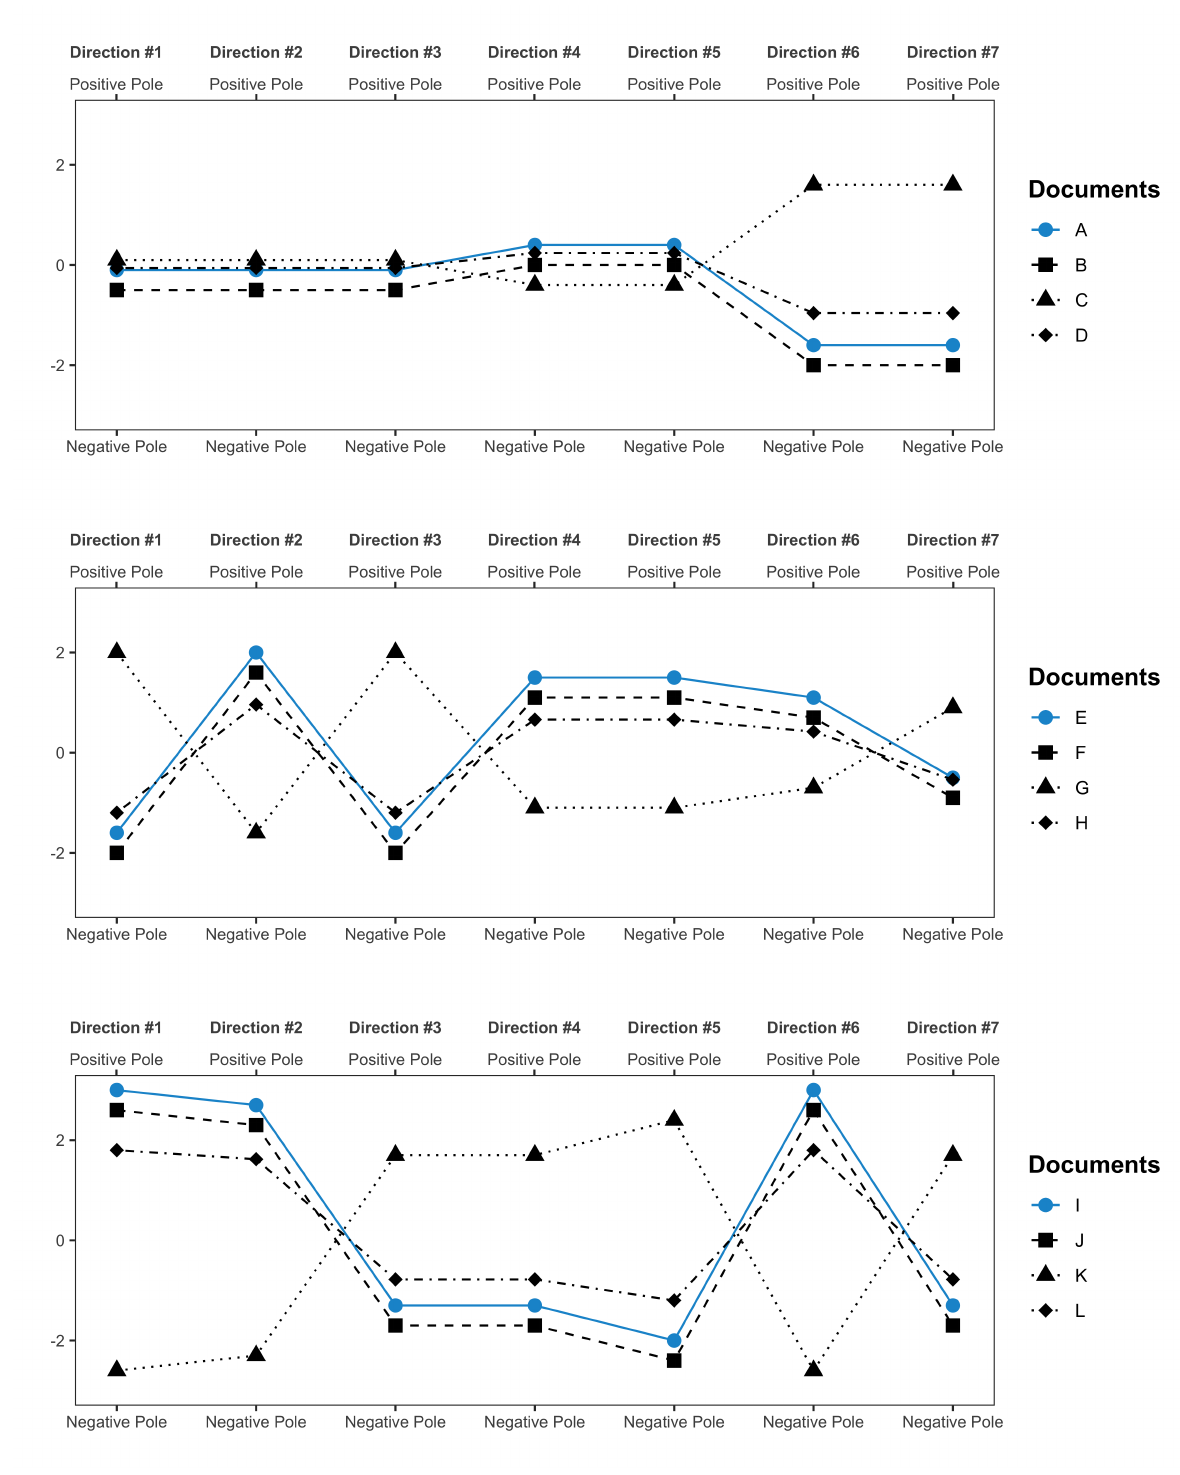
Figure 3: Three simulated schematic patterns. Note : The blue lines indicate the patterns from which each of the transformed patterns were